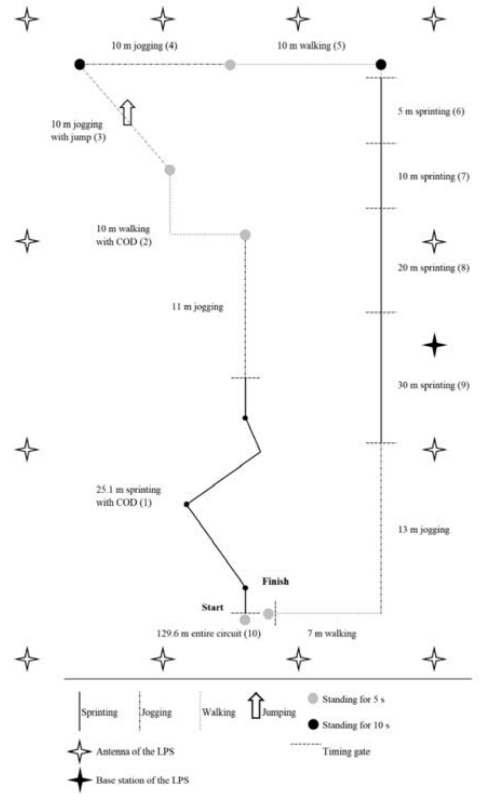
Figure 1. The design of the circuit and the setup of the local positioning system. Note: LPS = Local positioning system; COD = Change of direction. The particular sections that were used for determining the distances covered were numbered from 1 to 10 (in brackets) to allow a better assignment of the results provided in the tables and